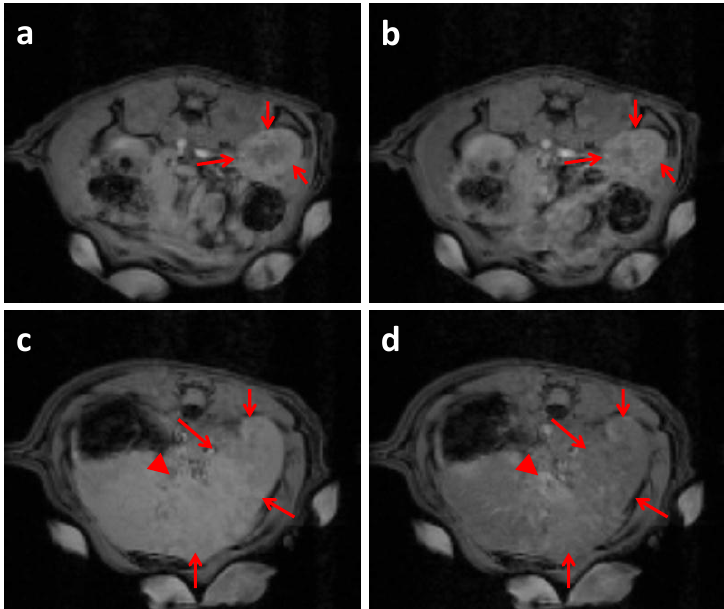
Figure 8. In vivo coronal T 1 -weighted images acquired from a male Sprague-Dawley rat at 7 T magnetic field. ( a , c ) Control (baseline) with no MNP administration. ( b , d ) Acquisition 30 min after GdSi nanoparticles injection (0.04 mmol Gd 3+ kg −1 ). Red lines show up kidneys ( a , b ) and liver ( c , d ).